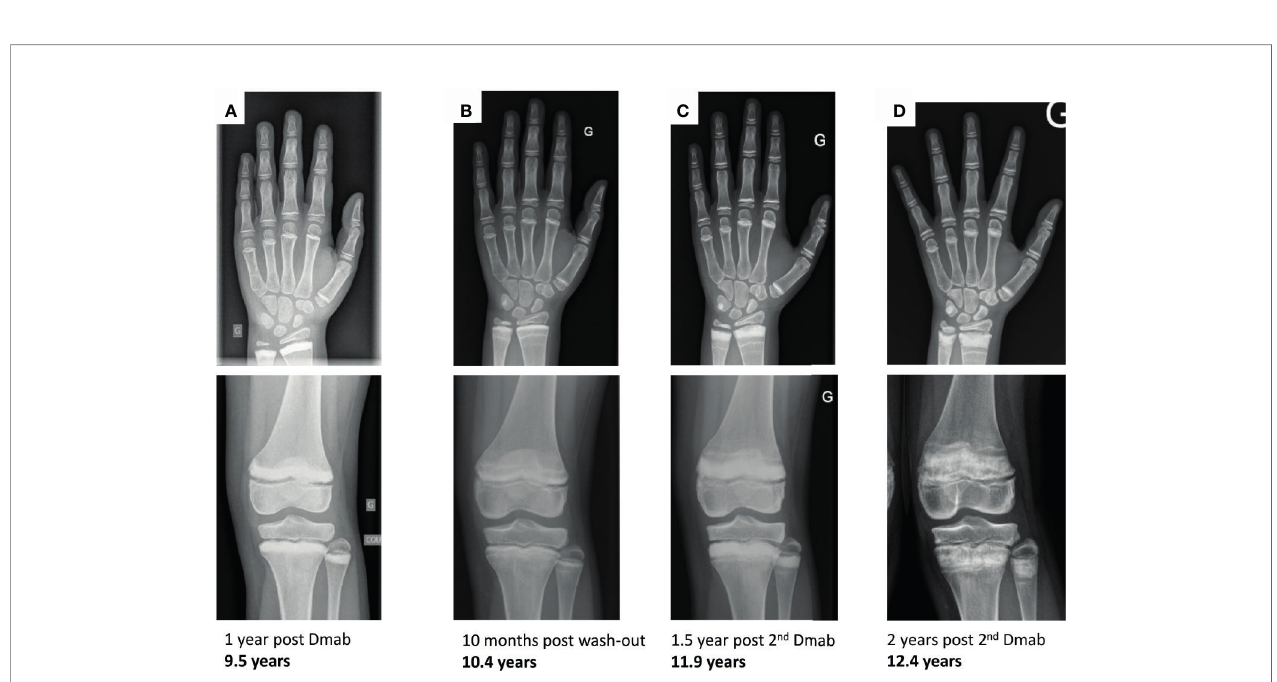
FIGURE 3 | Hand and knee radiographs during follow-up. Radiographs taken (A) after 1 year of denosumab (onset of sclerotic metaphyseal bands), (B) after 10 months of denosumab wash-out (reduction of sclerotic bands), (C) after 1.5 years of the 2 nd course of denosumab (more pronounced sclerotic metaphyseal bands) and (D) after 2 years of the 2 nd course of denosumab (severe and persistent sclerotic metaphyseal